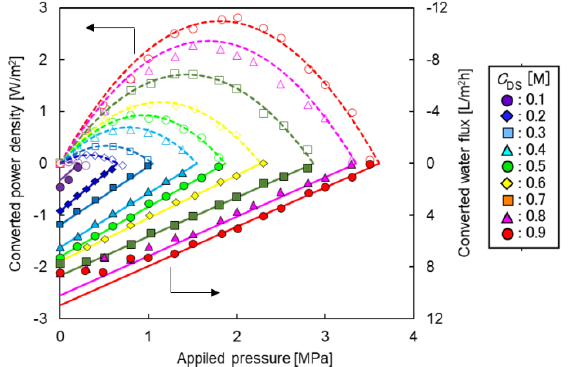
Figure 5. Converted power density and water flux as a function of applied hydraulic pressure with different DS concentrations ( C DS ). PRO conditions: FS, tap water; Q DS,in : 4.0 L/min; Q FS,in ; 1.5 L/min.